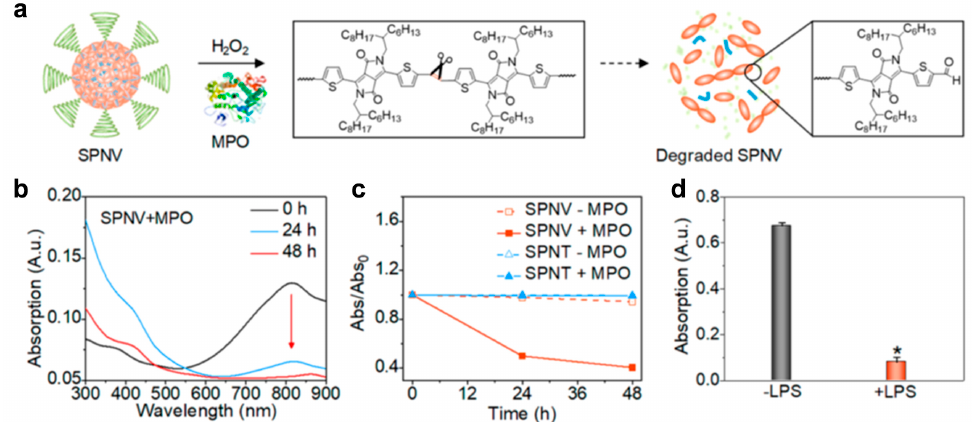
Polymers 2019 , 11 , x FOR PEER REVIEW Figure 9. In vitro biodegradability study of semiconducting polymer nanoparticles (SPNs). ( a ) Schematic illustration of the degradation of SPNV (SPN with vinylene groups) in the presence of myeloperoxidase (MPO) and H 2 O 2 . ( b ) Absorption spectra of SPNV in the presence of H 2 O 2 (300 µM) and MPO (50 µg mL –1 ) at 37 °C for 0, 24, and 48 h in phosphate buffer (50 mM, pH = 7.0) containing NaCl (150 mM). ( c ) Absorption decrease (Abs/Abs 0 ) of SPNV at 819 nm and SPNT (SPN without vinylene groups) at 828 nm in the absence or presence of MPO (50 µg mL –1 ) and H 2 O 2 (300 µM) as a function of incubation time. [SPNs] = 3 µg mL –1 . ( d ) Absorption intensity of SPNV at 819 nm after incubation with RAW264.7 cells (276,000 cells mL –1 ) treated with or without lipopolysaccharides (LPS). Error bars were based on the standard deviations (SD) of three parallel samples. * Statistically significant difference in cells treated with and without LPS (p < 0.005, n = 3). Reprinted with permission from [78]. Copyright, American Chemical Society (2018).